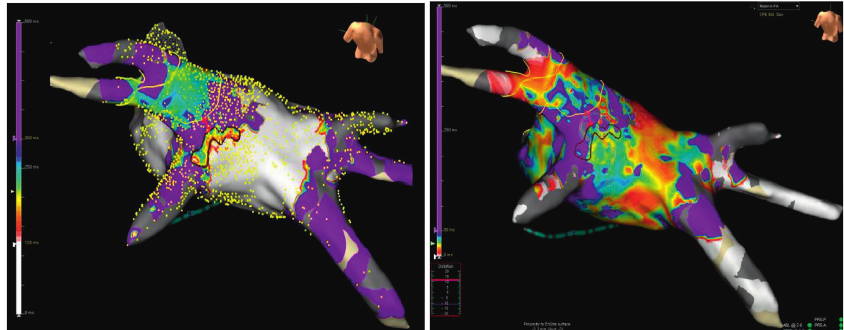
Figure 4: High-density mapping (12,275 points) performed with the 3D Precision System and HDGrid omnipolar catheter (Abbott) to research during atrial fibrillation of rotational activity (RA). The figure on the left shows a map during AF that allows identifying areas of interest compatible with rotational activity (cycle length mean map, CLmean), with activity between 120 and 300msec. Areas of interest appear in sets of different colors, while insignificant areas appear as white and purple (below 120 msec and above 300msec, respectively). On the right side, the figure shows the standard deviation map (SD map) of the same activity during AF (cycles length between 0 and 50msec), in order to establish whether the rotational activity identified with the CLmean (at the level of the posterior wall near the left inferior pulmonary vein) is stable over time. The set of different colors indicates stable rotational activity in this region (SD between 0 and 50msec).